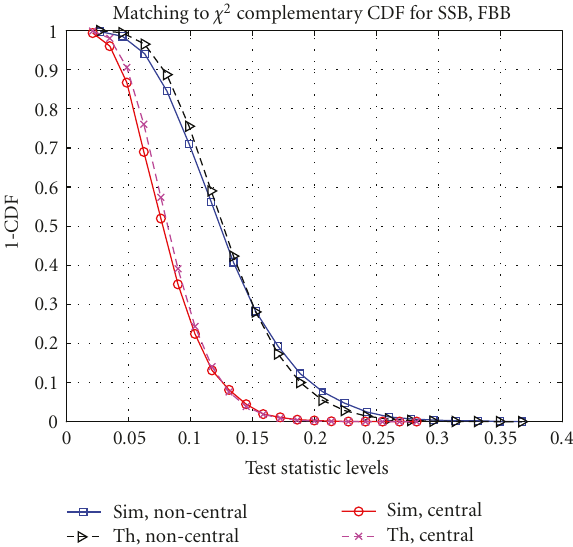
Figure 6: Matching with χ 2 distributions, (complementary CDF: 1-CDF), theory (th) versus simulations (sim), FBB ep , N fb = N pieces =